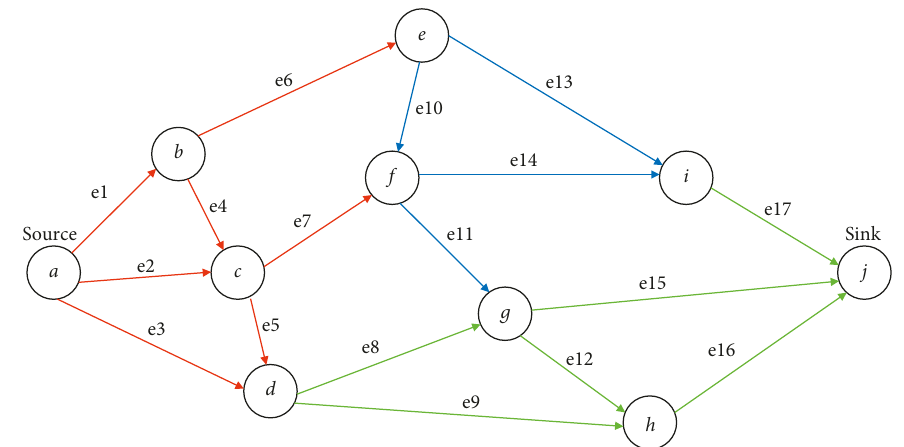
Figure 14: Network system with 10 edges and 17 vertices. Table 15: Parameters used in optimization (Example 3).